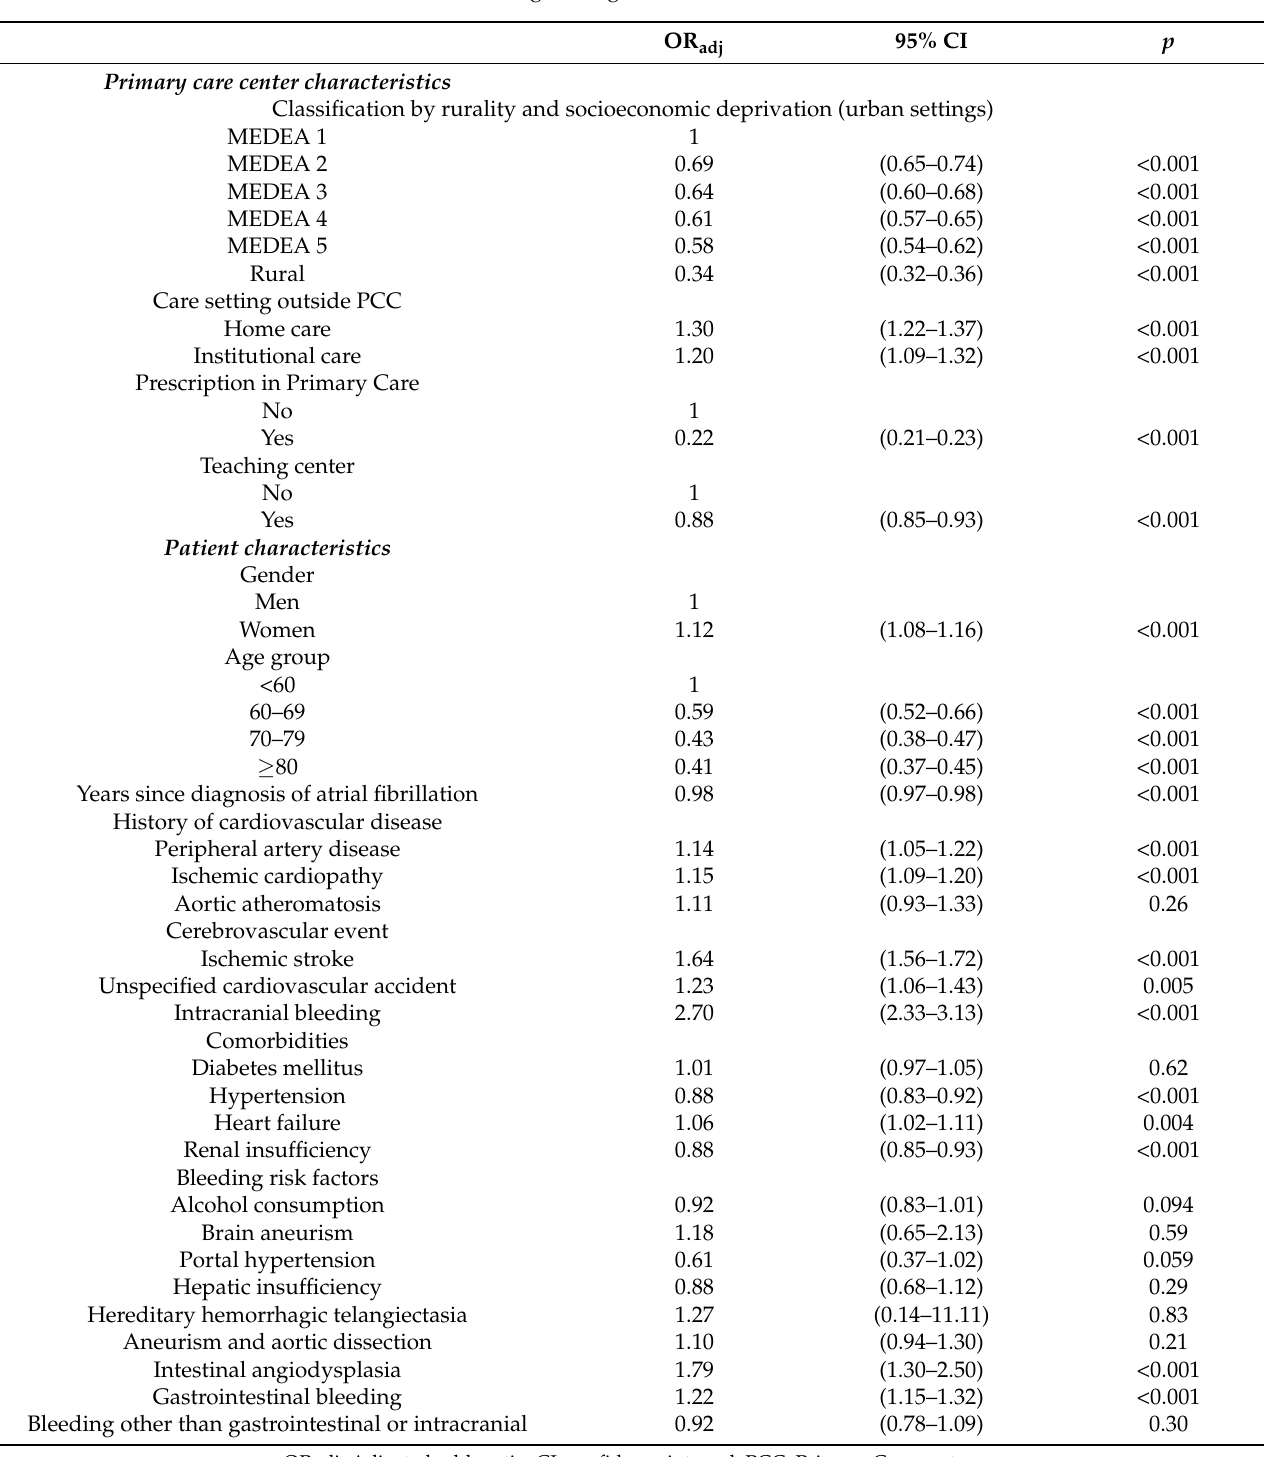
Table 2. Association between the prescription of direct anticoagulants versus vitamin K antagonists according to patient- and center-related characteristics. Multivariable logistic